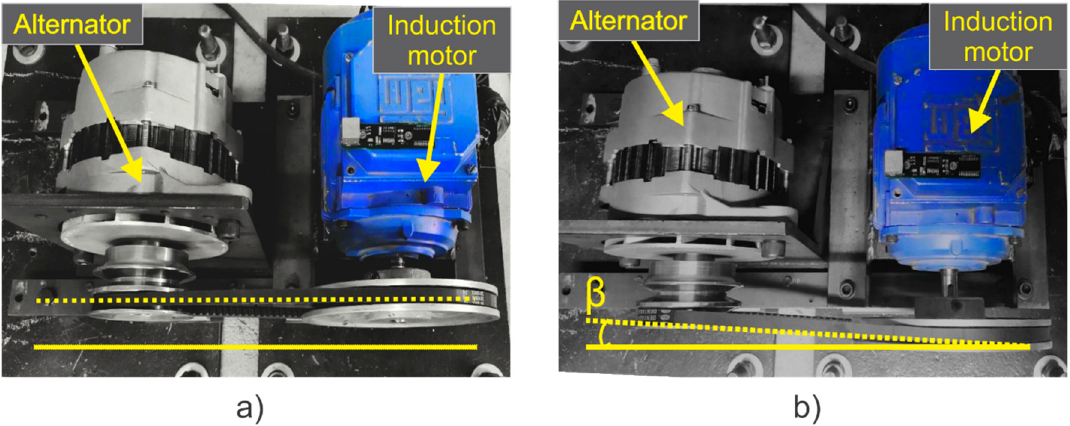
Figure 11. ( a ) Motor aligned; ( b ) motor misaligned.